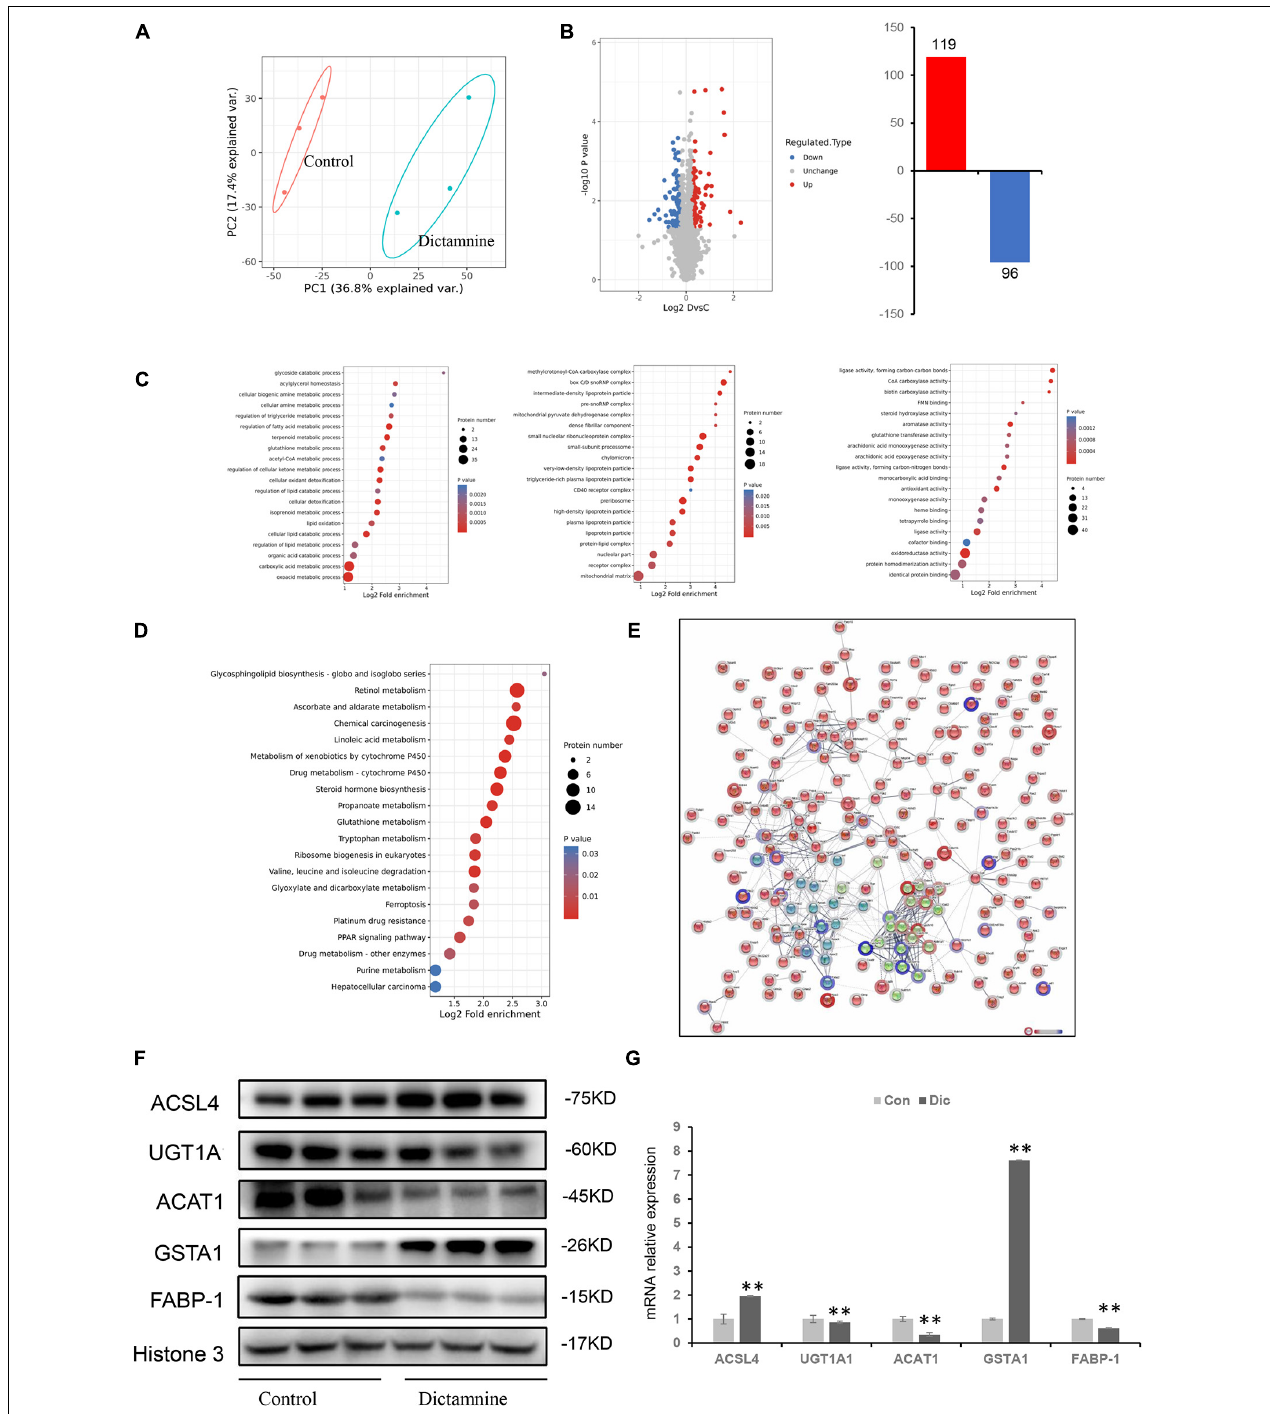
FIGURE 4 | Proteomic analyses of livers of dictamnine-treated mice and untreated control. (A) PCA score plot for the differentially expressed proteins in control and dictamnine group. (B) The volcano plot (log2 Fold Change vs. –log10 P -value) of the up-regulated and down-regulated proteins dictamnine-treated mice and the untreated control. (C) Enrichment analysis of GO terms for the differentially expressed proteins. (D) KEGG pathway analysis for the differentially expressed proteins in livers of dictamnine-treated mice and untreated control. (E) Network analysis for the enriched pathways and protein-protein interactions. (F) Western blot analysis of protein expression levels of ACSL4, UGT1A1, ACAT1, and GSTA1 between the two groups. Densitometric analysis shows protein levels relative to Histone 3. (G) qRT-PCR analysis of proteins expression levels of ACSL4, UGT1A1, ACAT1, FABP-1, and GSTA1. Values presented as means ± SD ( n = 3), ∗∗ P < 0.01, vs. Con.